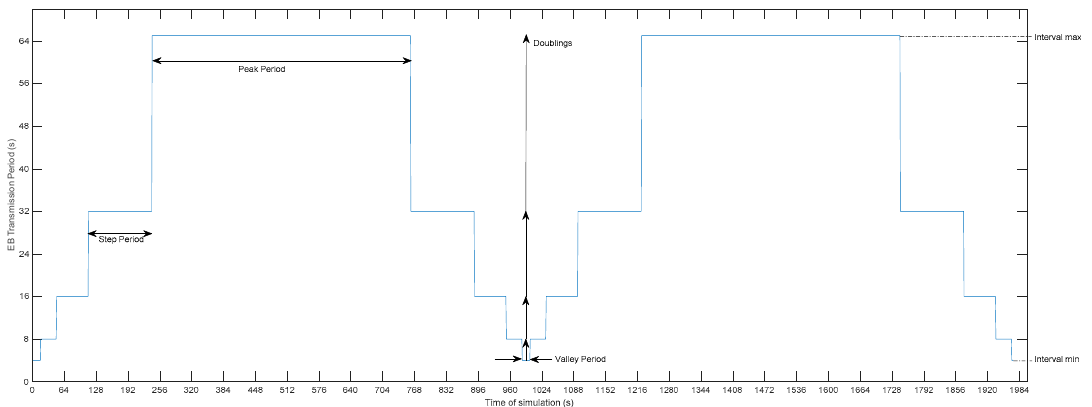
Figure 5. Example of a possible Bell-X configuration (Interval min: 4 s – Doublings: 4 – Valley factor: 4 – Step factor: 4 – Peak factor: 8).